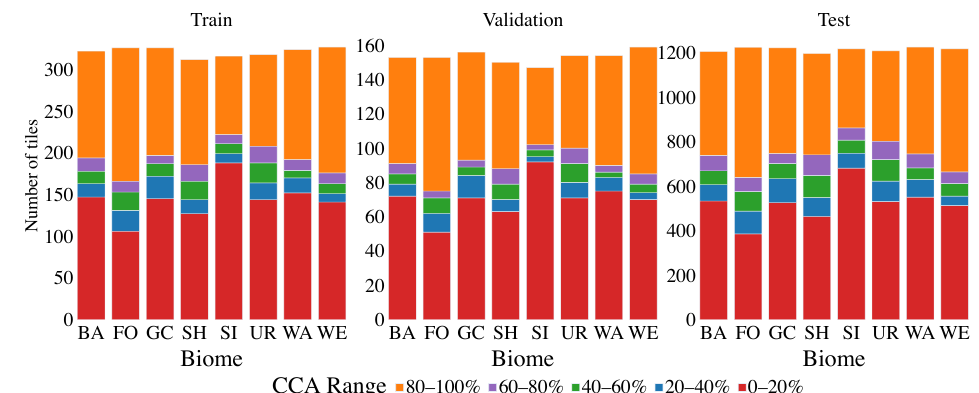
Figure 6. Distribution of the tiles and its CCA values per biome for the training, validation and testing